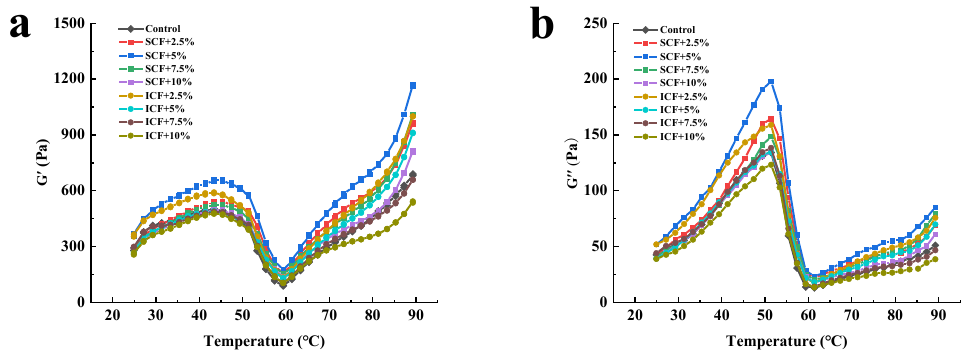
Figure 2. The G (cid:48) ( a ) and G (cid:48)(cid:48) ( b ) of the MP gels with different treatments. Figure 2. The G′ ( a ) and G′′ ( b ) of the MP gels with different treatments. 3.6. LF-NMR .